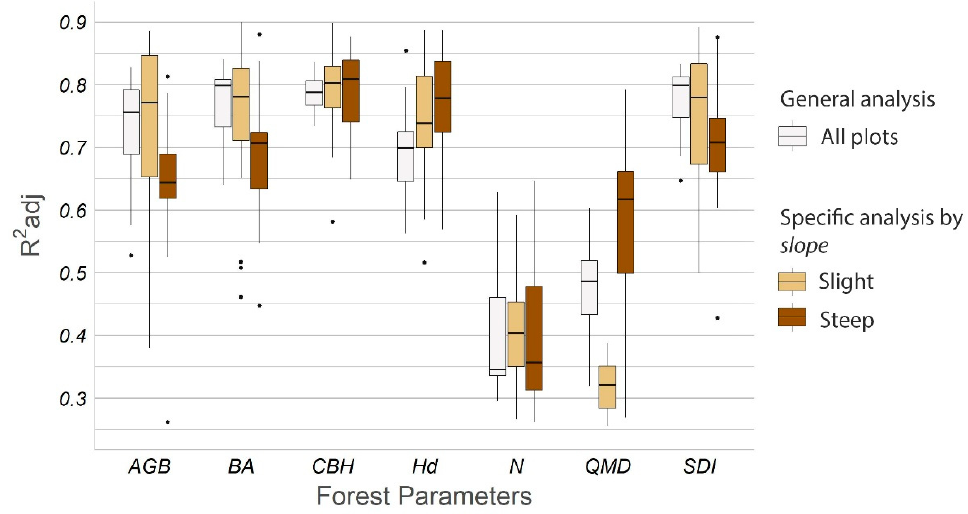
Figure 6. Box and whiskers plot of the adjusted R 2 obtained from the estimate of each forest parameter and each of the 31 combinations of scan number and position. White boxes represent the adjusted R 2 obtained by combining all 28 plots, light brown boxes represent the 14 plots with a slight slope, and dark brown boxes represent the 14 plots with a steep slope.